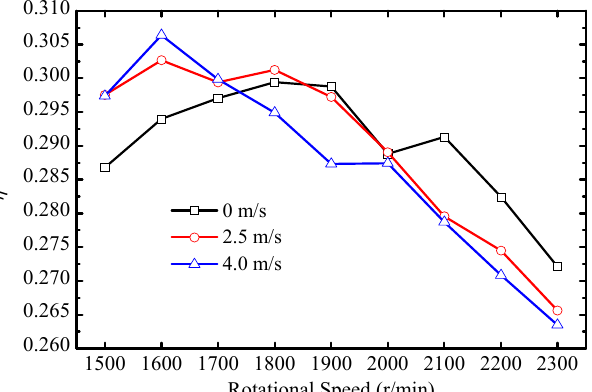
Figure 7. Hover e ffi ciency η at di ff erent wind speeds. Figure 7. Hover efficiency η at different wind speeds.